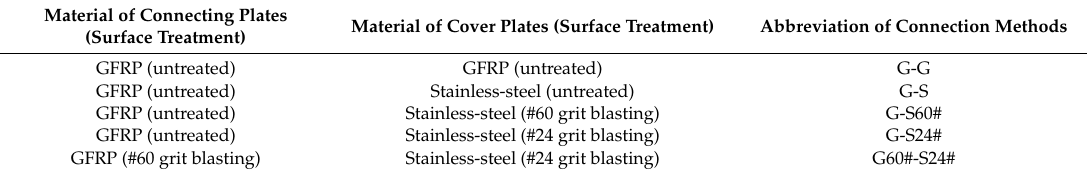
Table 3. Abbreviations for each connection method.